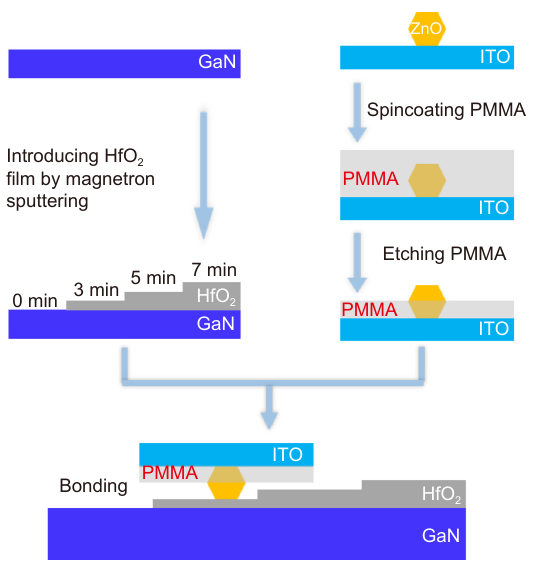
Fig. 1 | The diagram of device